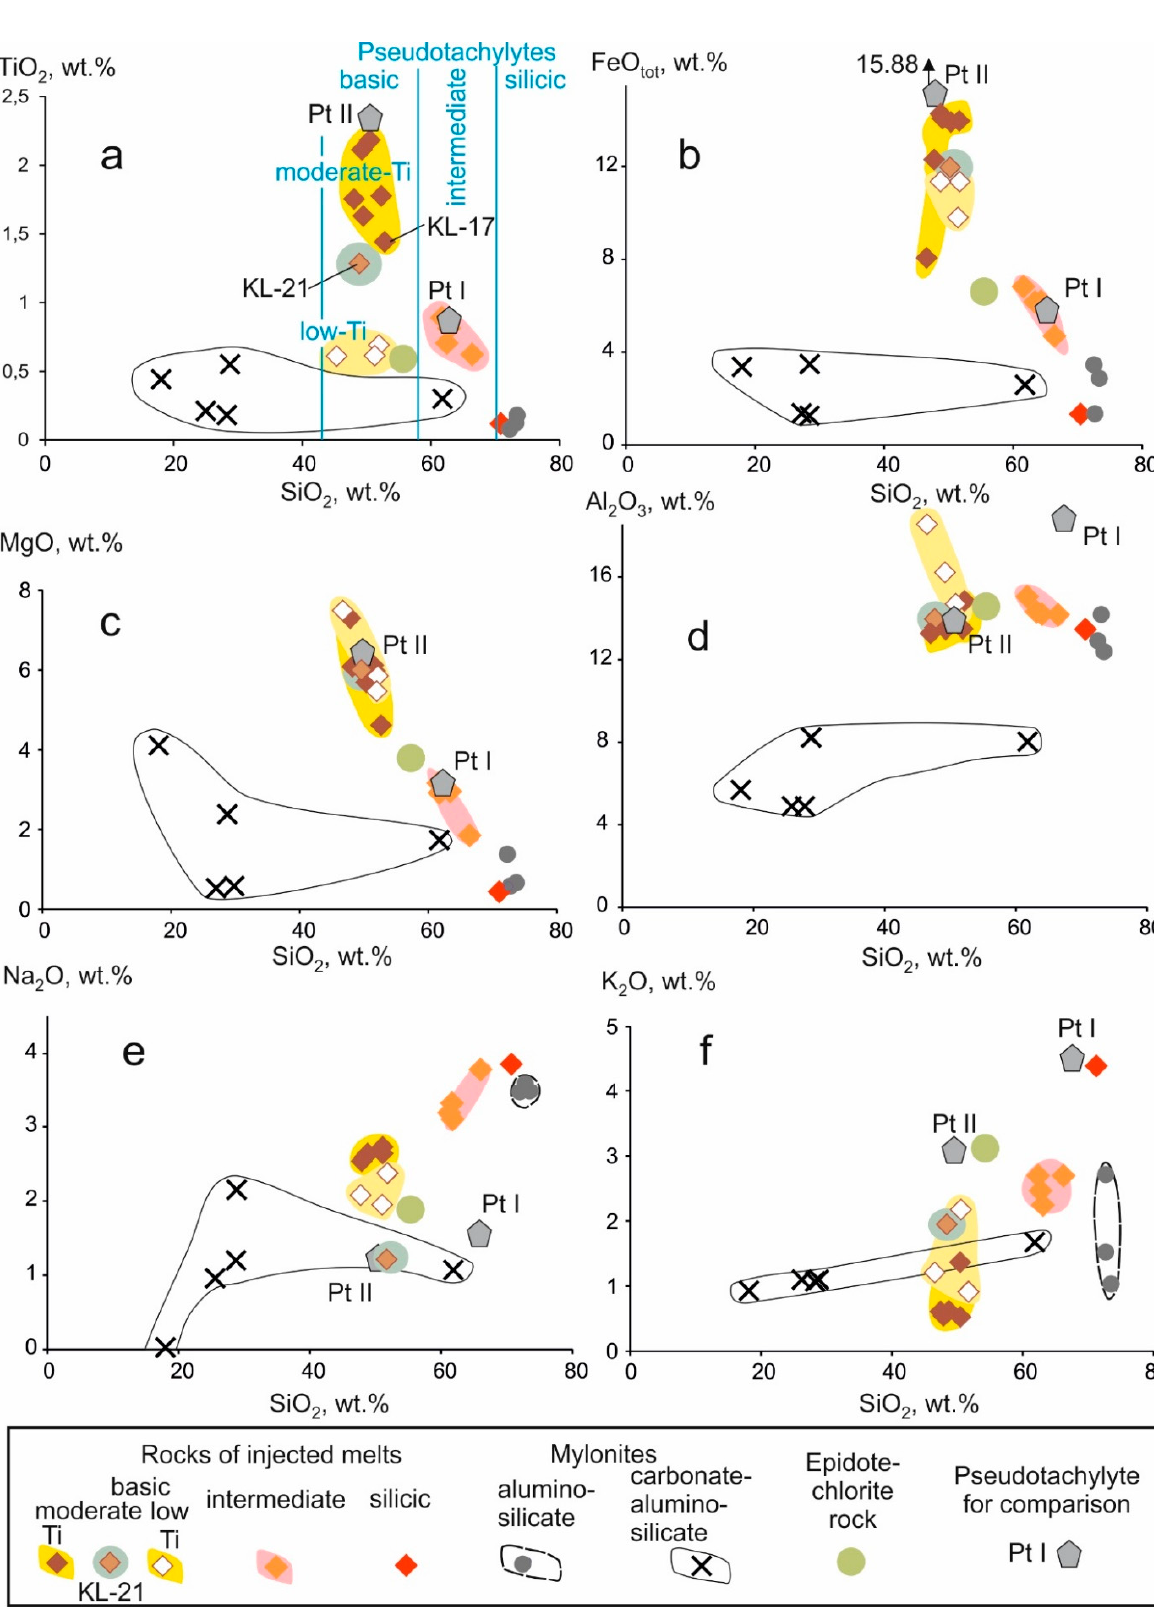
Figure 4. Grouping of rocks of injected melts and mylonites and their relationships with the epidote-chlorite rock from the MSF on diagrams of SiO 2 plotted versus oxides: ( a ) TiO 2 , ( b ) FeO tot , ( c ) MgO, ( d ) Al 2 O 3 , ( e ) Na 2 O, and ( f ) K 2 O. Shown for comparisons are two types of pseudotachylyte compositions: Pt I from gneiss; Pt II from a contact between gneiss and metadolerite [32]. In diagrams, measured major oxide values are used.